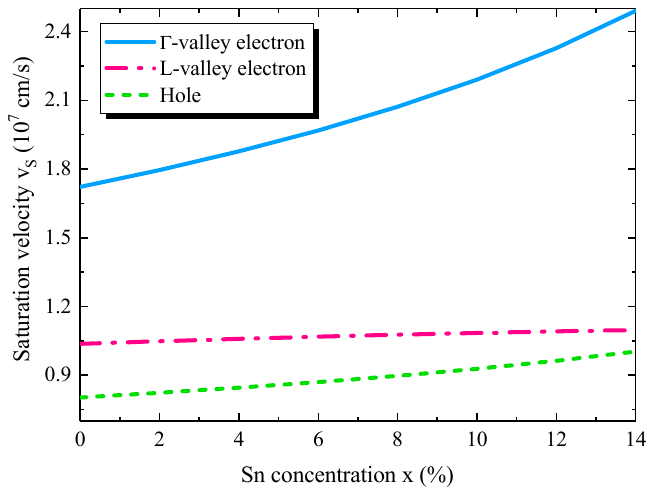
Figure 5. Calculated carrier saturation velocity as a function of Sn concentration inside the active region.